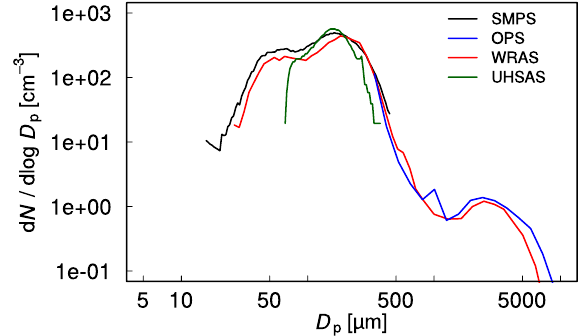
Figure 26. Intercomparison of the median particle number size dis- tributions from the SMPS, OPS, WRAS, and UHSAS instruments. Instruments were operated for 6h using the same inlet line during clean rainy-season conditions (26 January 2015).